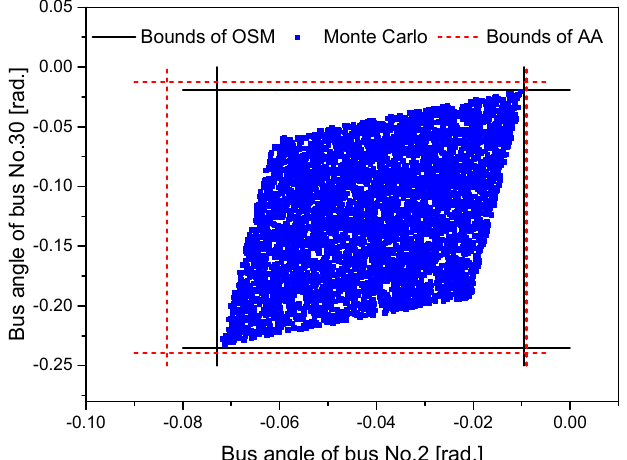
Figure 10. Sampling results of bus angles at bus No. 2 and bus No. 30.